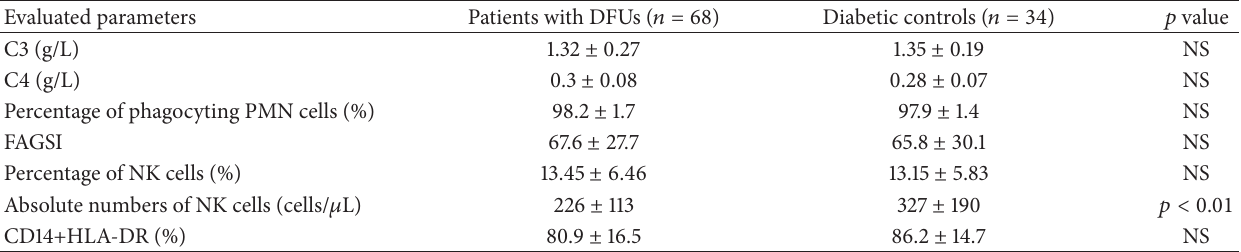
Table 2: The differences in selected parameters of innate immunity between the study groups.